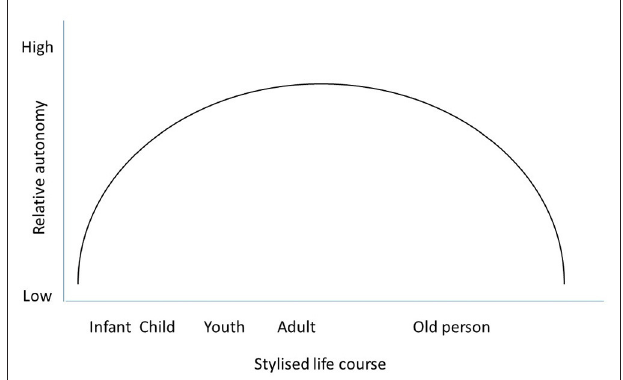
FIGURE 1 | Changes in relative autonomy and independence during a stylised life course. Source: